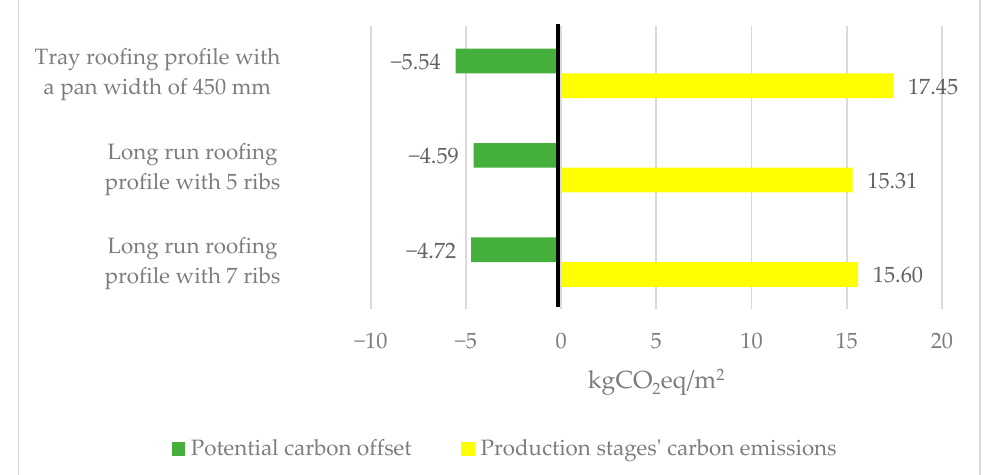
Figure 4. Comparison between average GWP values from the production stages and the potential carbon offset from each investigated metal roofing product.